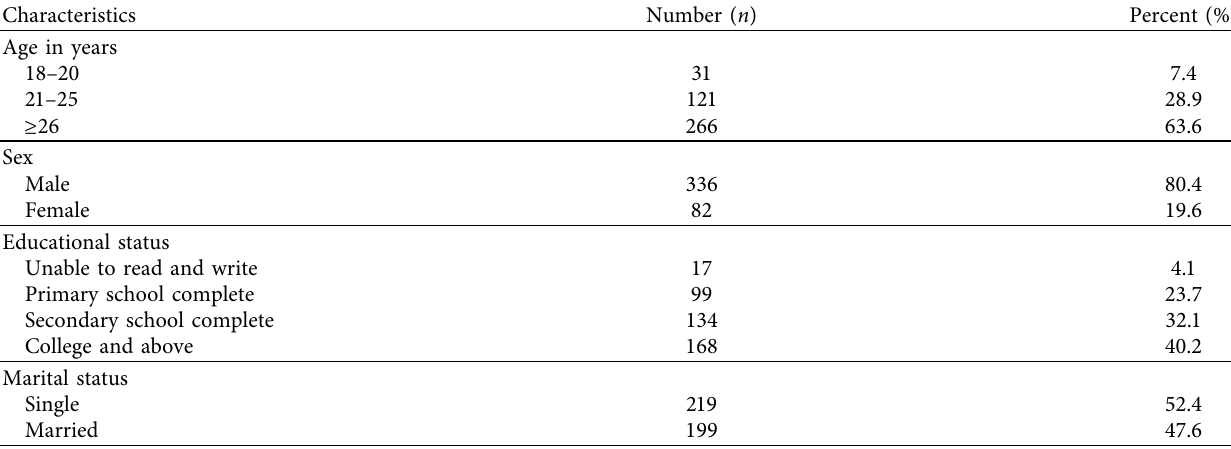
Table 1: Sociodemographic characteristics of voluntary blood donors at Bahir Dar Blood Bank, Northwest Ethiopia, 2020 ( n � 418). Characteristics